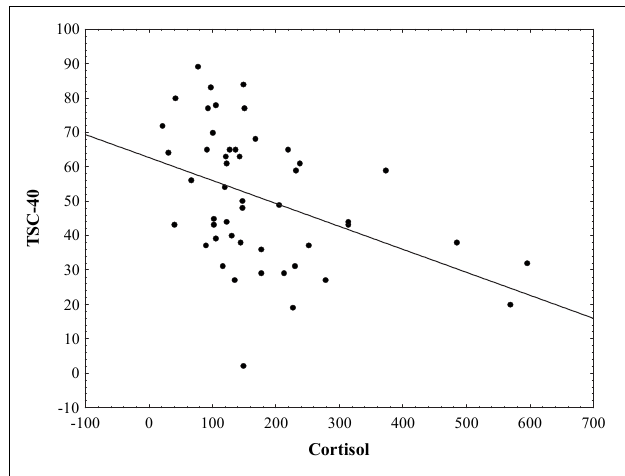
FIGURE 1 | Relationship between hair cortisol levels (pg/mg) and stress symptoms measured by